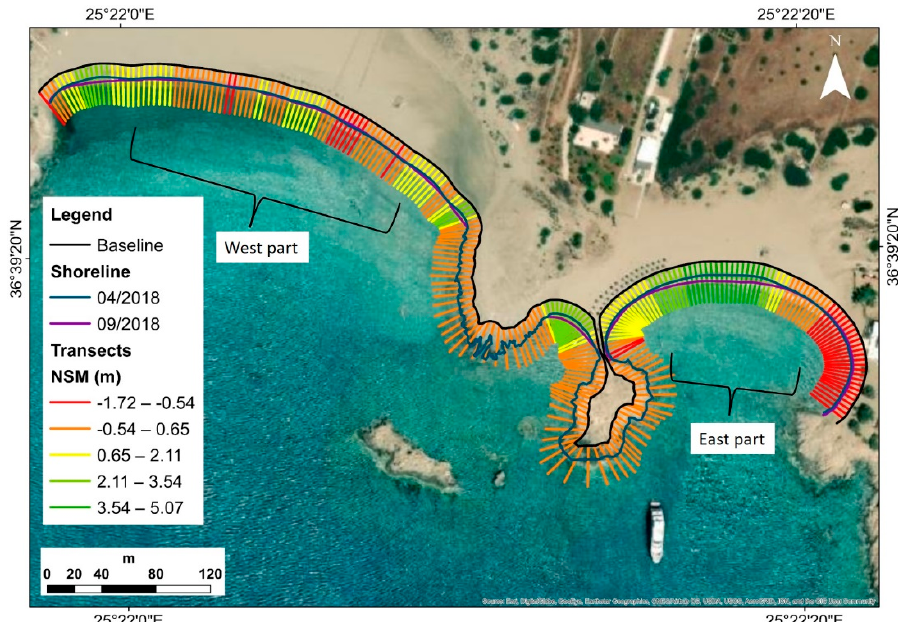
Figure 16. Map of seasonal displacement of the shoreline at Magganari beach.